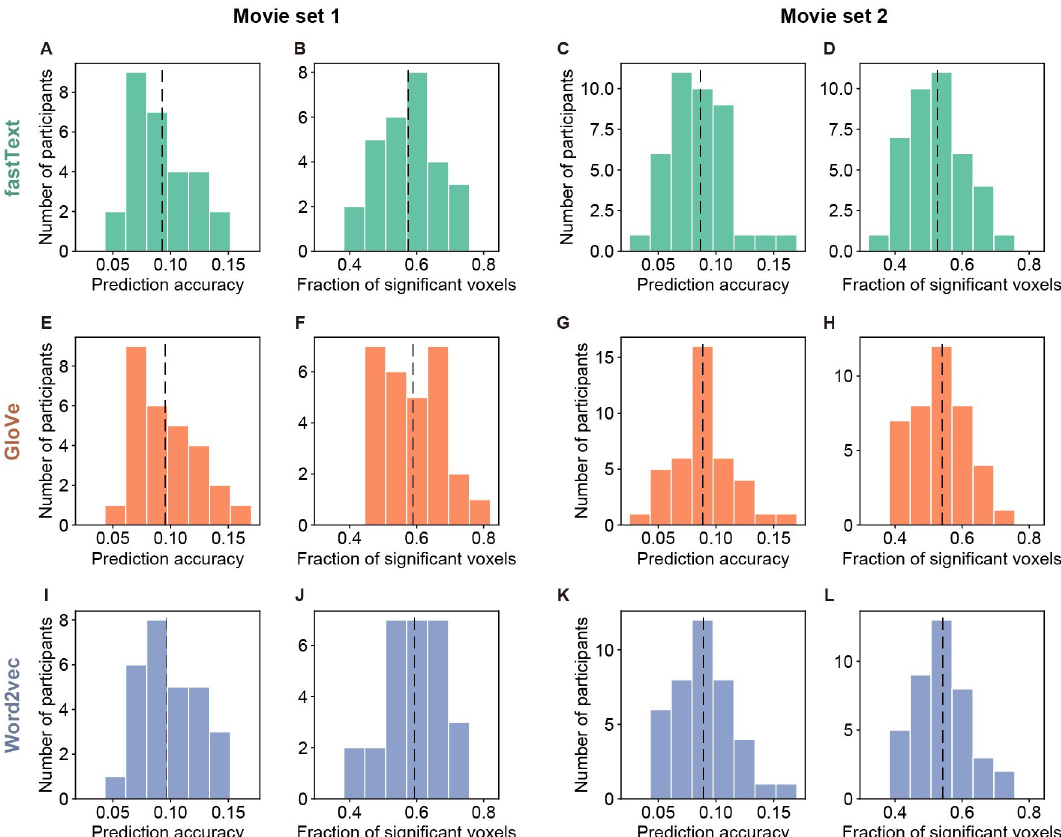
Fig 3. Performance of voxelwise models in brain-response prediction. The performance of voxelwise models (vector dimension = 1000) was evaluated in terms of predicting brain responses in the test dataset. For this purpose, prediction accuracy and the fraction of significant voxels for each brain were calculated for each type of word vectors ( A – D , fastText; E – H , GloVe; I – L , word2vec). The distribution of prediction accuracy ( A , C , E , G , I , and K ) and that of the fraction of significant voxels ( B , D , F , H , J , and L ) were separately shown for movie sets 1 ( A – B , E – F , and I – J ) and 2 ( C – D , G – H , and K – L ). The vertical dashed line in each panel indicates the prediction accuracy averaged across participants.